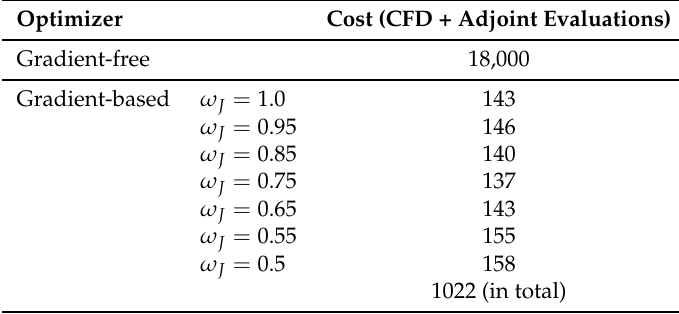
Table 2. Computational cost comparison of the gradient-free (Differential Evolution) algorithm and the gradient-based (Sequential Quadratic Programming)